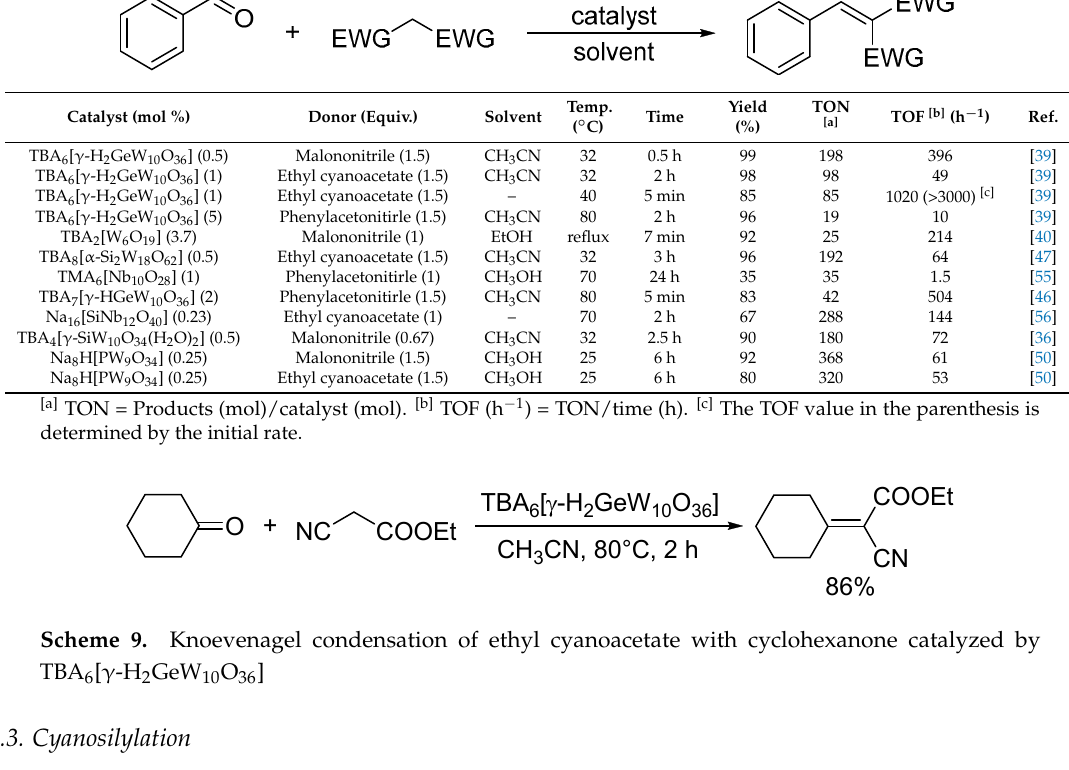
Table 2. Knoevenagel condensation of benzaldehyde with active methylene compounds by POM base